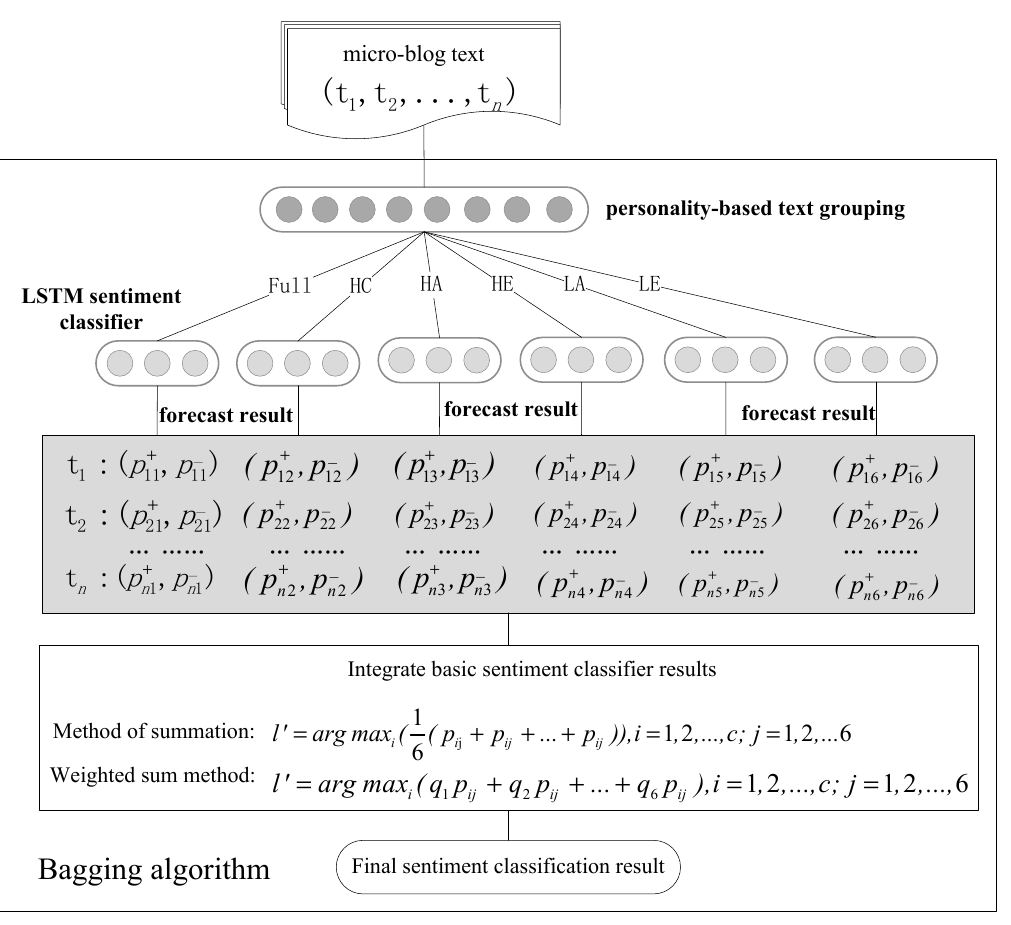
Figure 3. The process of integration of sentiment classifiers.